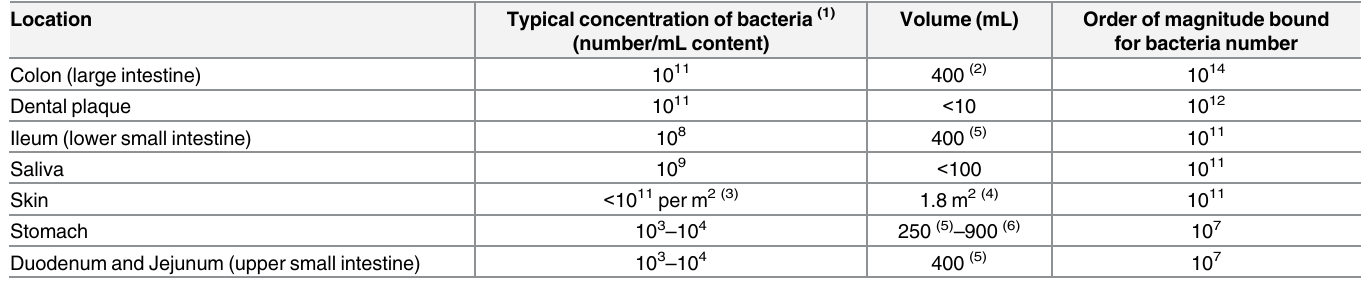
Table 1. Bounds for bacteria number in different organs, derived from bacterial concentrations and